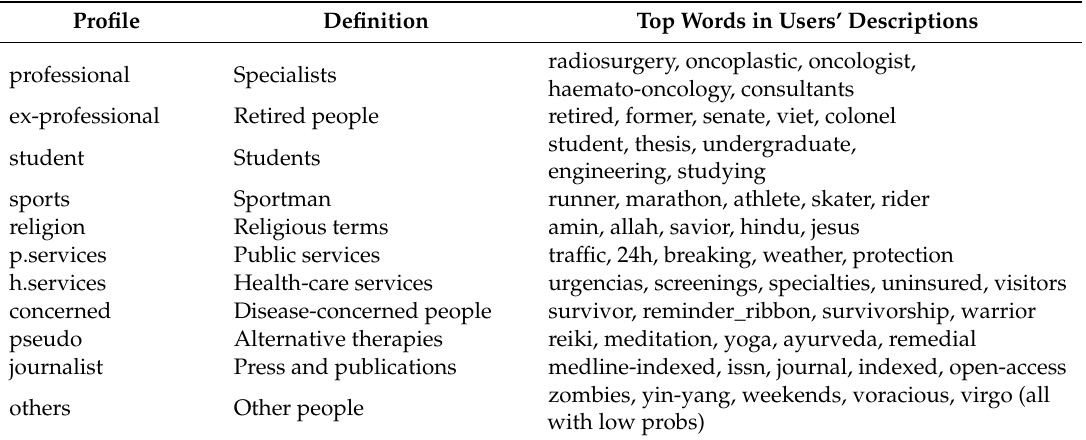
Figure 3. Comparing profiles from different topics and events (authors in blue and audience in red): ( a ) Top: Leukemia (topic), Bottom: Carlos Carrasco (event) ( b ) Top: Skin Cancer (topic), Bottom: Tapeworm (event). Table 7. Language models for different profiles according to the users' descriptions.